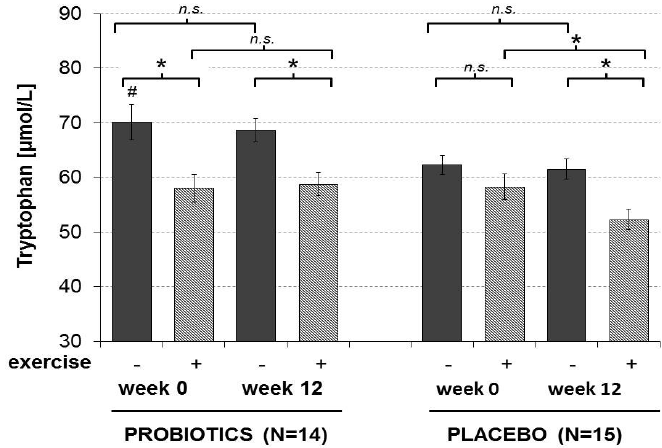
Figure 4. Tryptophan concentrations before and after exhaustive exercise in the probiotic ( n = 14) and placebo ( n = 15) group of trained athletes before and after 12 weeks of treatment (four blood draws per athlete). Graph shows mean ± SEM; * p < 0.05: Wilcoxon, # p < 0.05: week 0, before exercise placebo vs. probiotics: Mann ‐ Whitney ‐ U , n.s. = not statistically significant.